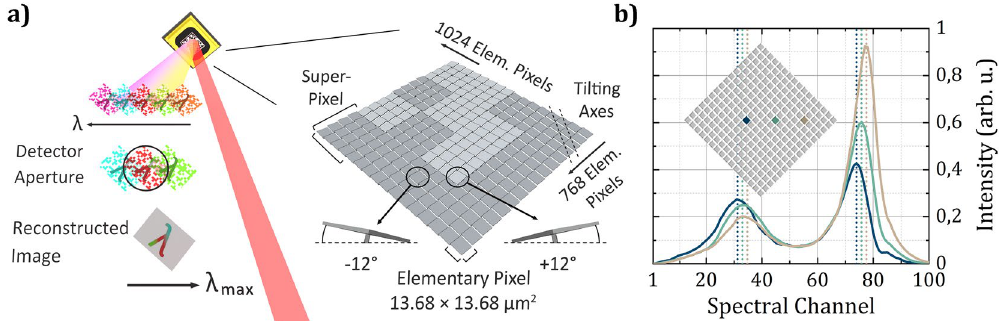
Figure 2. ( a ) Visualization of an exemplary section of the DMD array (right) and principle of operation (left). The DMD spatially masks the captured scene and disperses it due to diffraction at the micromirrors. Overlapping spatially coded images of different wavelengths are at least partially projected on the detector and thus lead to a spectral gradient along the image diagonal. ( b ) Spectral data of three exemplary spatial channels of a hyperspectral 16 × 16 image resulting from block averaging 64 × 64 images of a USAF resolution test